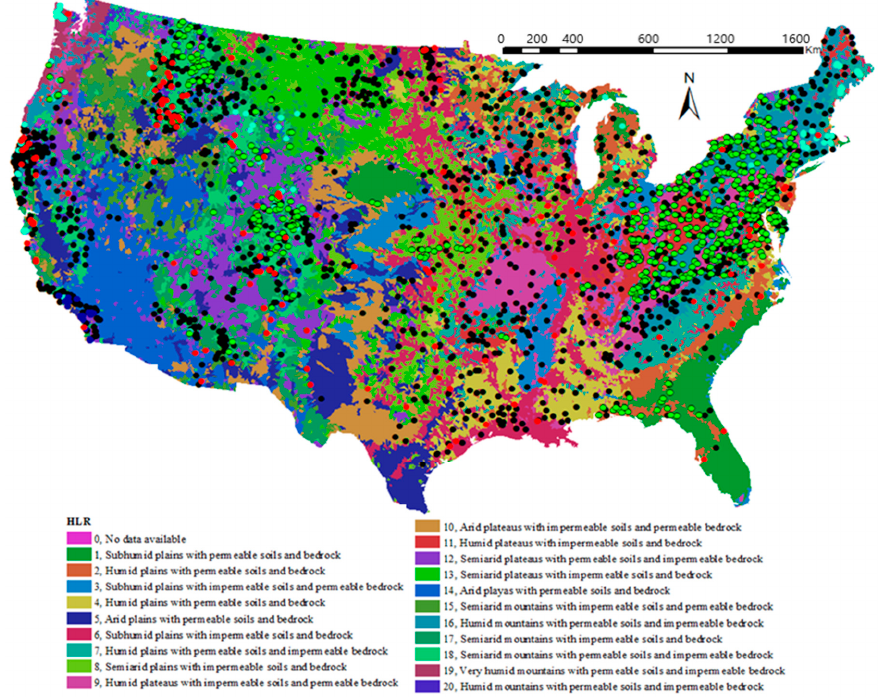
Figure 9. Distribution of D50 data points over HLR. Colors on the background map represent HLRs.